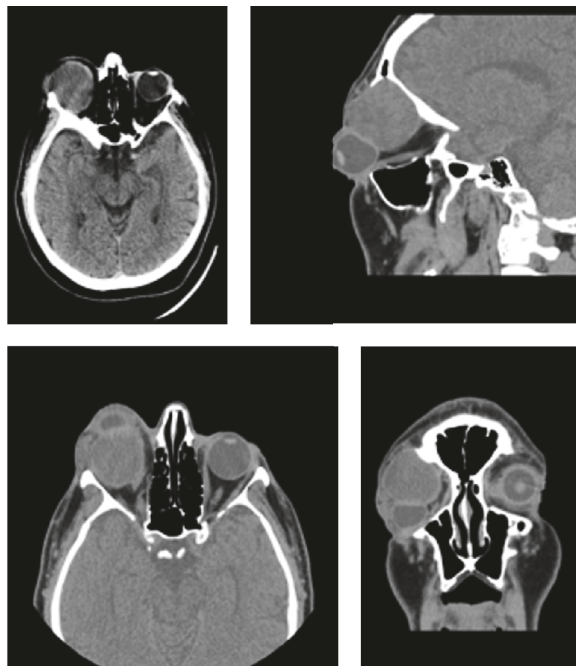
Figure 1: CT axial, sagittal, and coronal views of cyst causing proptosis.